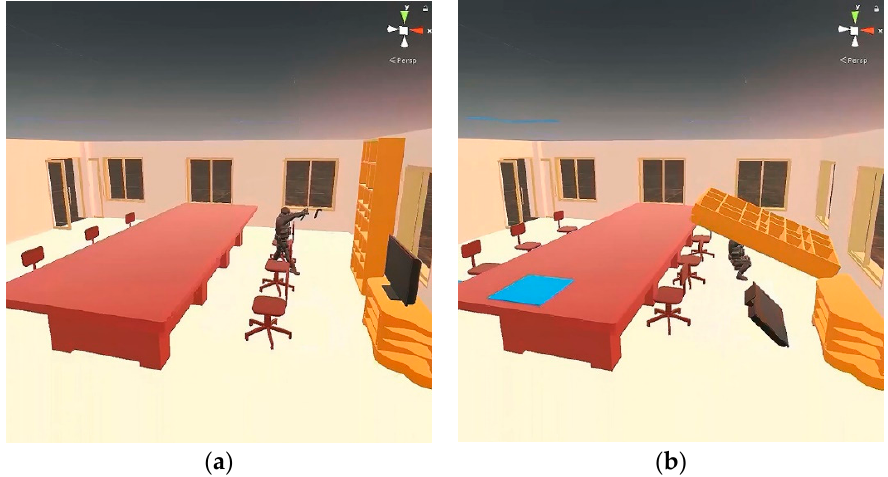
Figure 16. The first drill without the awareness of nonstructural damage, ( a ) response; ( b )